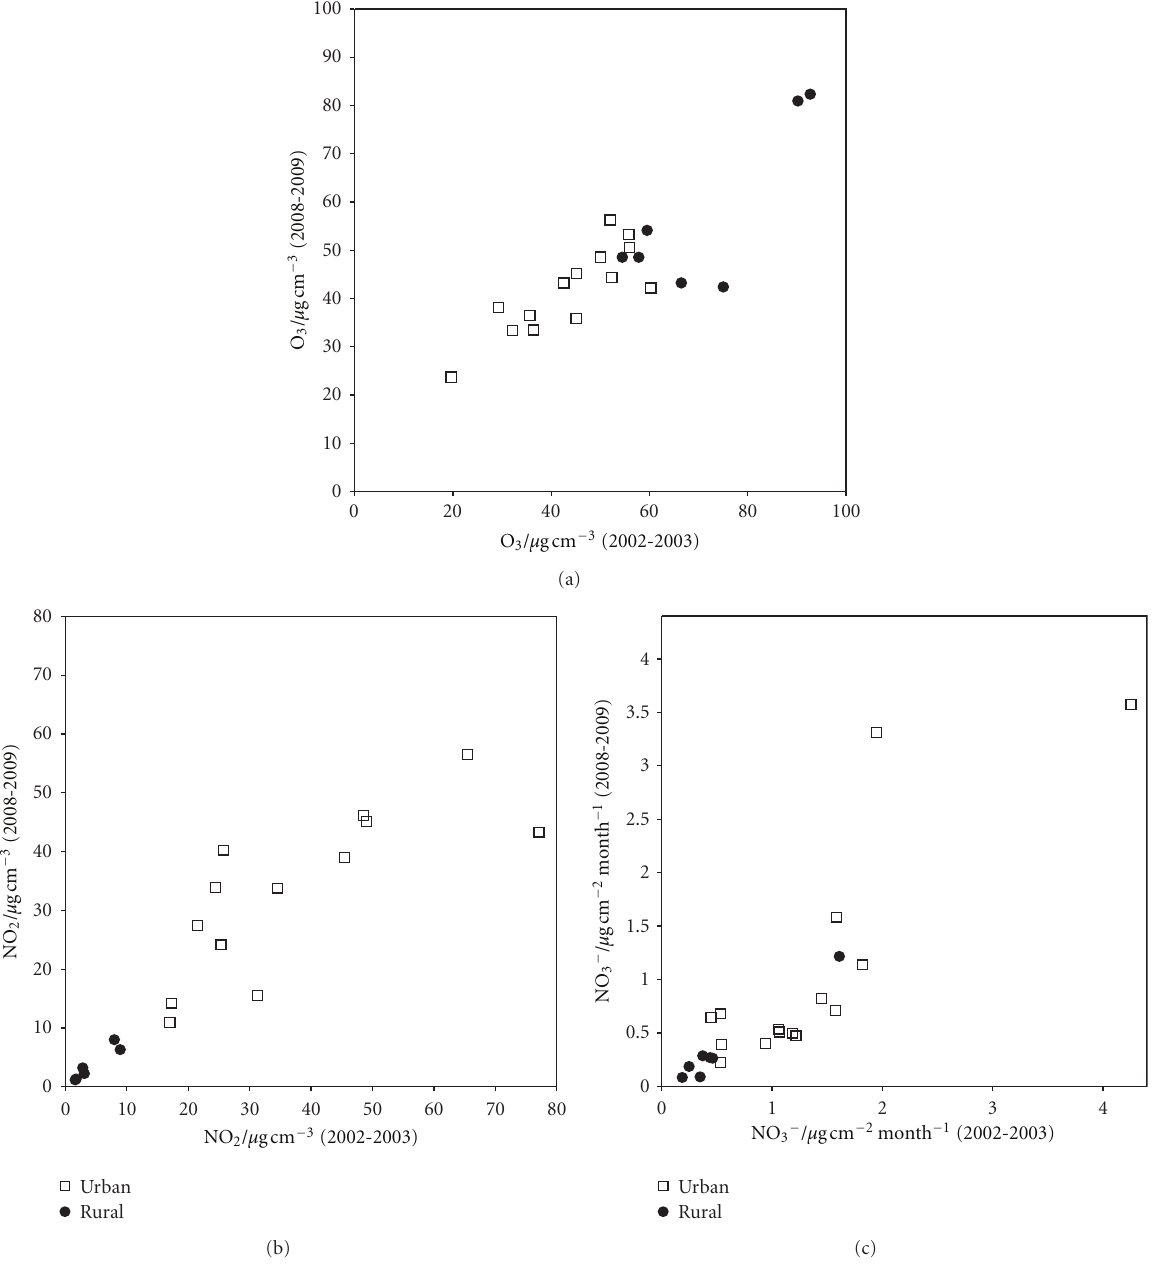
Figure 7: Annual average O 3 concentration, NO 2 concentration, and NO 3 − deposition at ICP Materials test sites for the two one-year campaigns 2002-2003, and